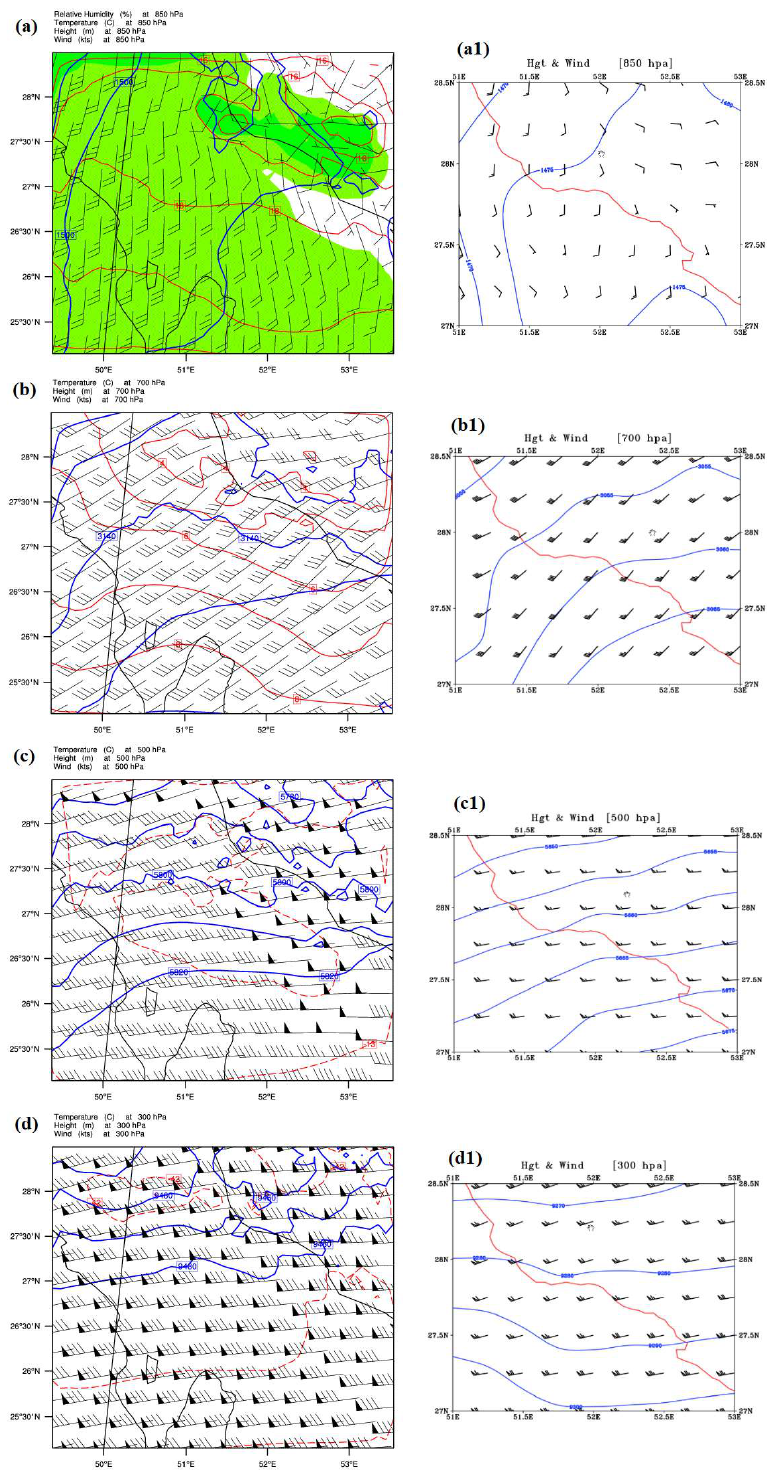
Figure 10. Geopotential height (blue lines), wind direction and wind speed (vectors), and isotherm contours (black lines) at 850 ( a ), 700 ( b ), 500 ( c ), and 300 ( d ) hPa. Panels from ( a1 ) to ( d1 ) present the same quantities with higher resolution for the coastline affected by the storm surge.